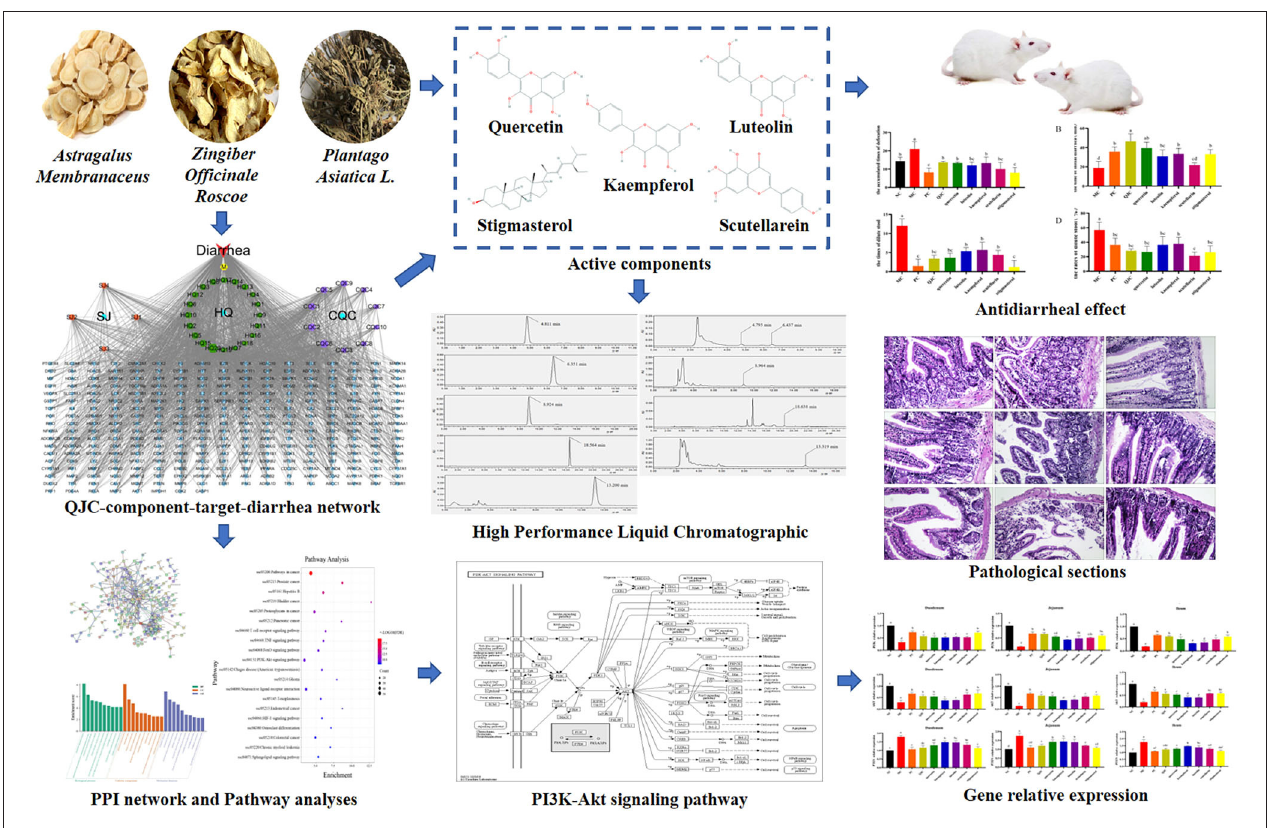
FIGURE 1 | The experimental